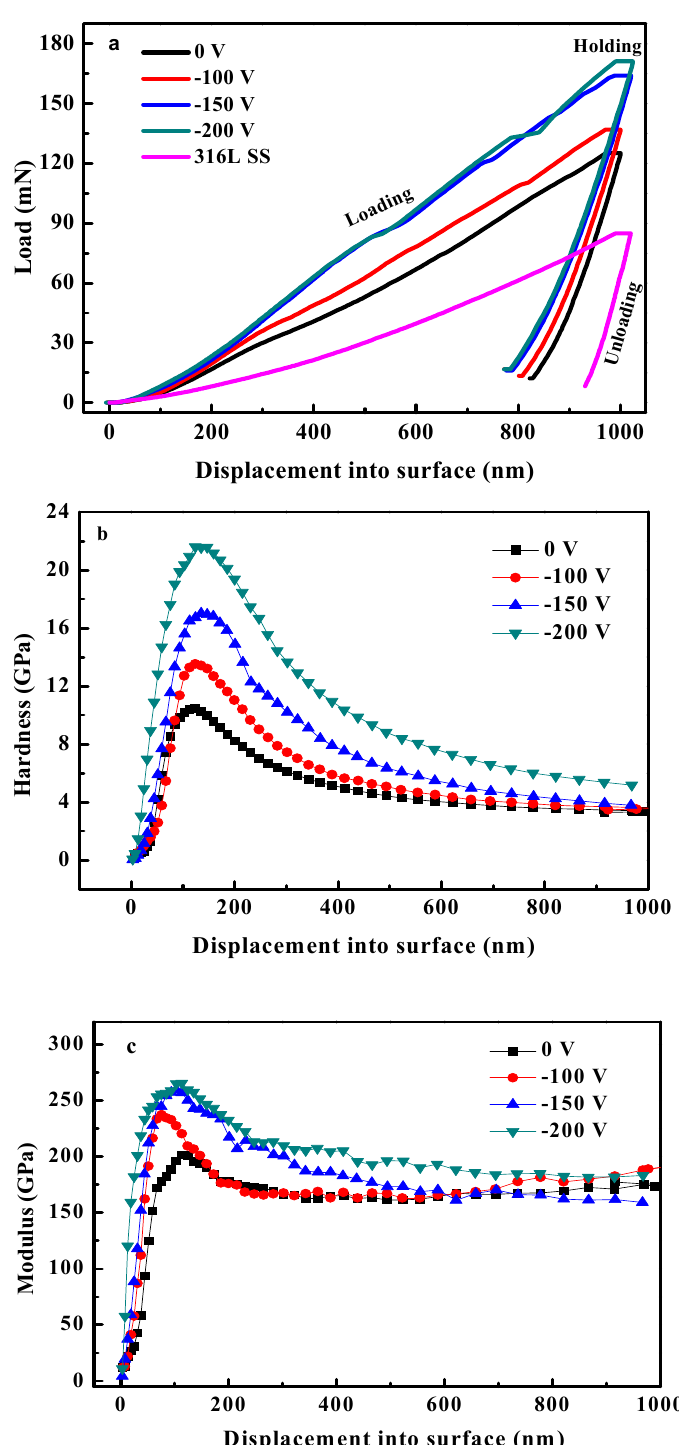
Figure 7. Nanoindentation load–displacement curves ( a ), hardness–displacement curves ( b ), and